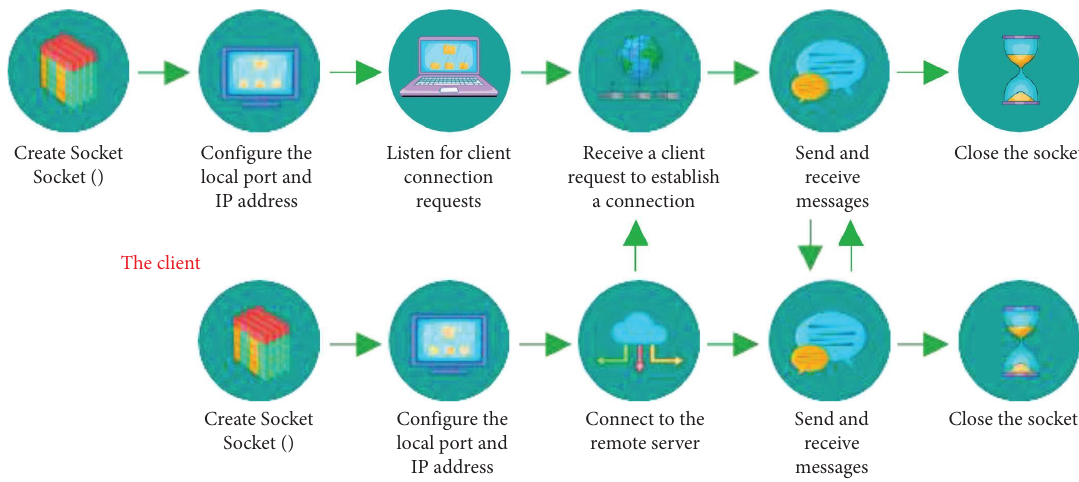
Figure 5: TCP/IP communication protocol